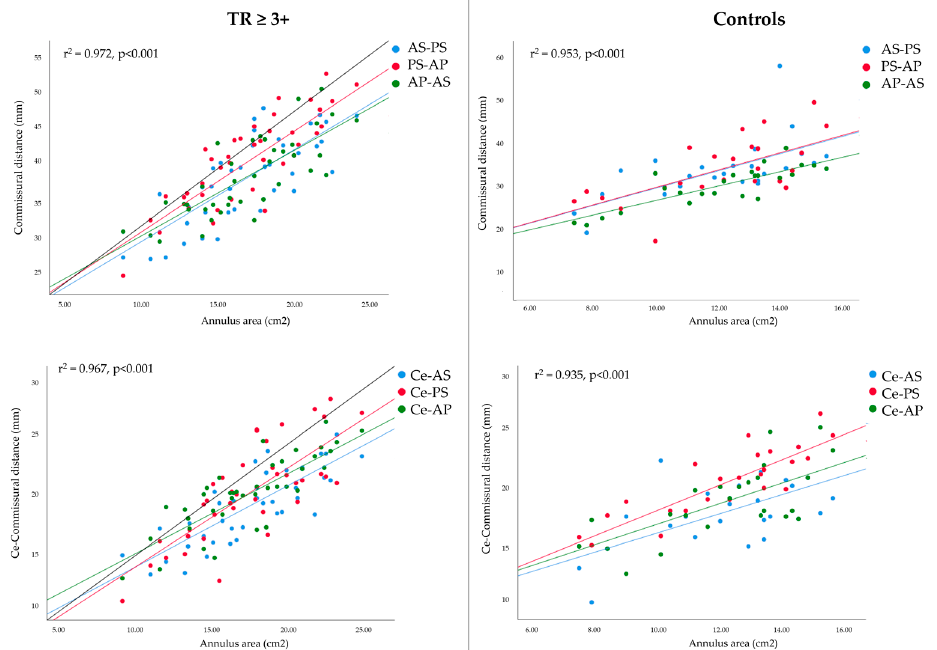
Figure 3. Multiple regression lines showing the relationship between CT dimensions (distance